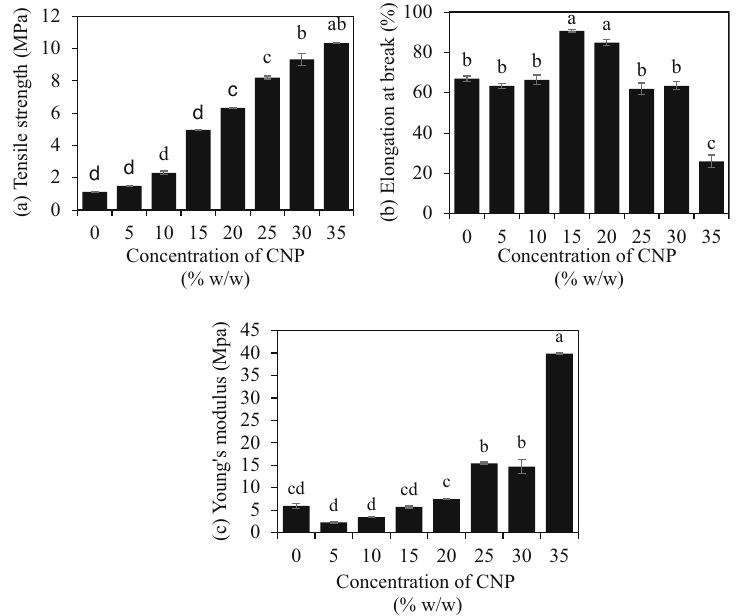
Figure 3: E ff ects of CNP concentrations on mechanical properties of starch fi lms: ( a ) tensile strength, ( b ) elongation at break, and ( c ) Young ’ s